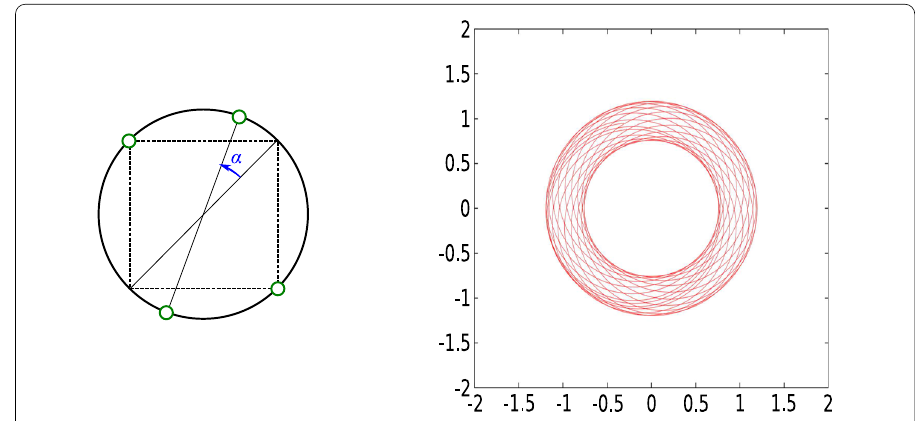
Fig. 8 Angularly perturbed initial configuration (left) and trajectory (right)